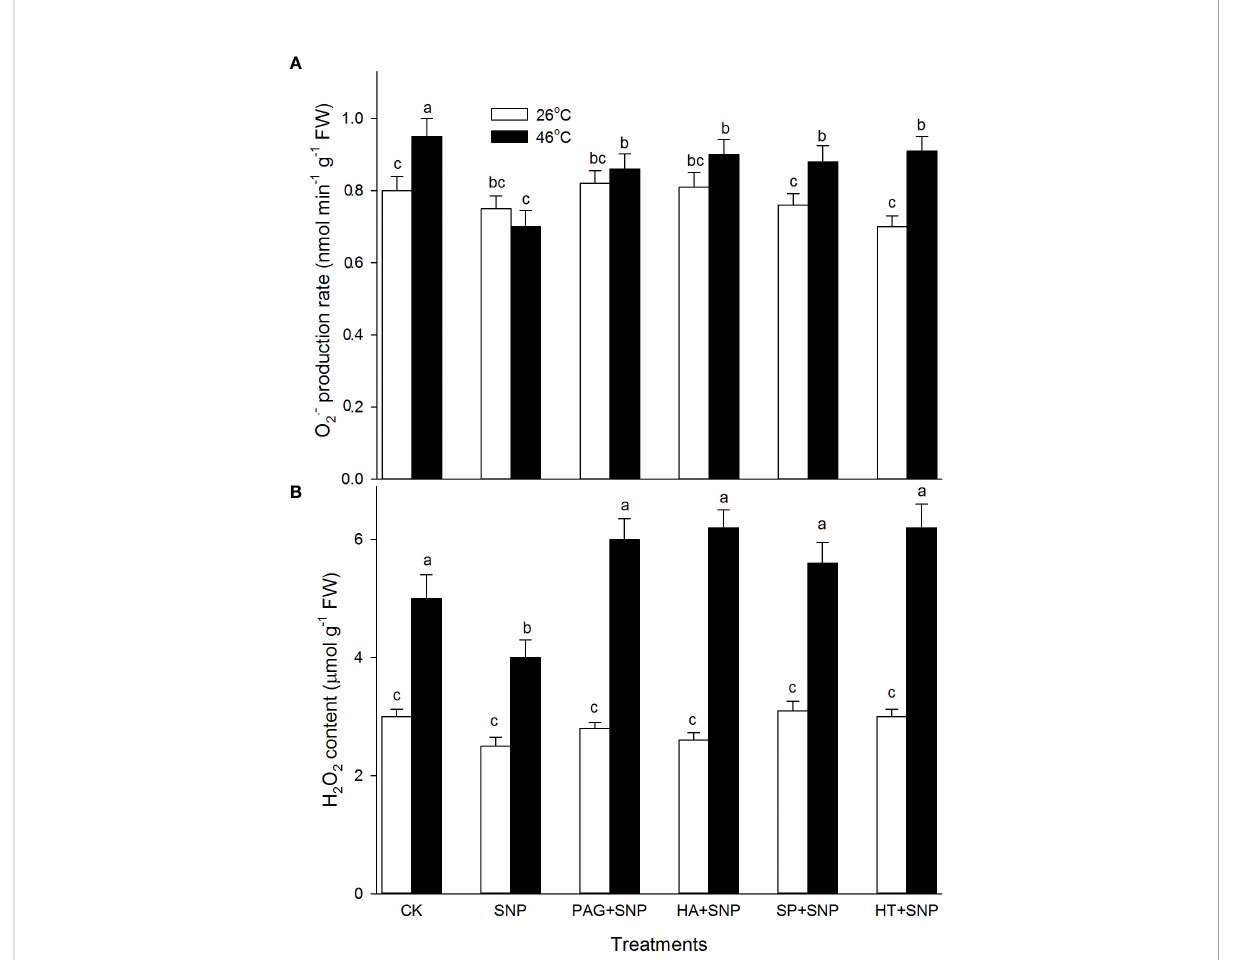
FIGURE 8 Effect of SNP alone or in combination with hydrogen sul fi de (H 2 S) inhibitors and scavengers on superoxide radical (O 2.- ) production rate (A) and hydrogen peroxide (H 2 O 2 ) (B) contents in maize seedlings under non-HS and HS conditions. The data had at least three biological replicates and were tested using Duncan's multiple-range test at 0.05 signi fi cant level, which denote means ± standard error (SE). The bars with the different letters represent signi fi cant differences, while the same letters represent no signi fi cant